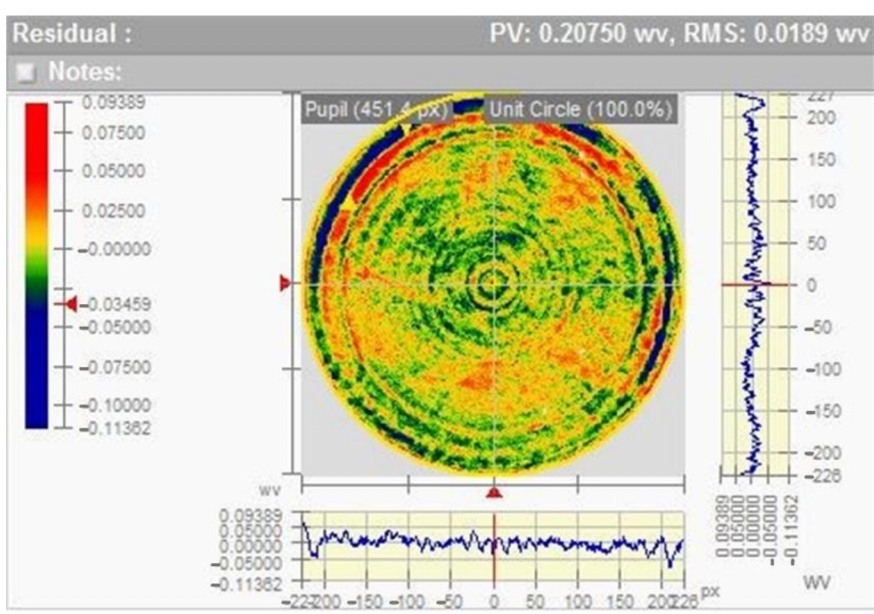
Figure 11. The interferogram of Zygo